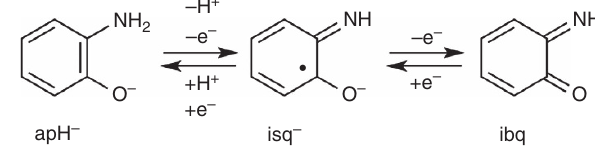
Figure 1 | Electron- and proton-transfer properties of apH (cid:2) . On removal of one proton and one-electron, o -aminophenolate (apH (cid:2) ) reversibly affords o -iminosemiquinonate (isq (cid:2) ), which is reversibly transferred into o - iminobenzoquinone (ibq) on a further one-electron